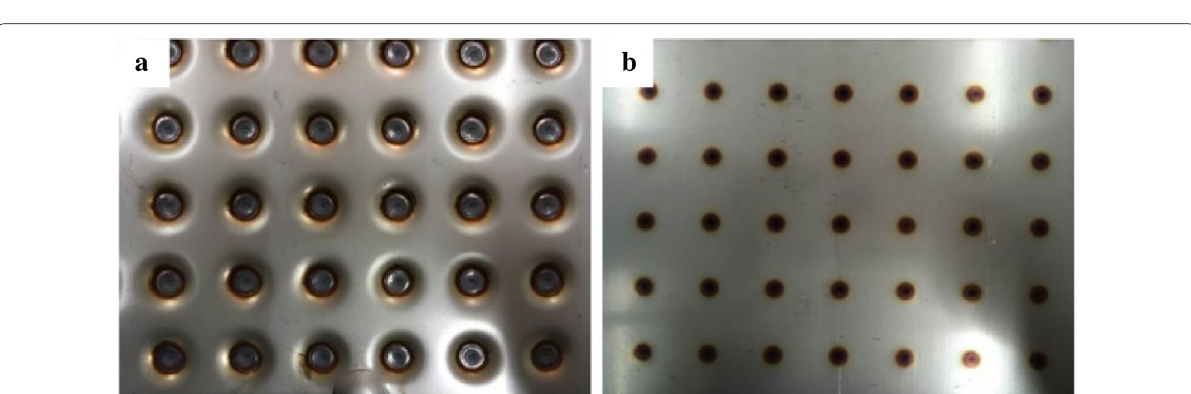
Figure 30 Welding seam morphology of the plate-pair laser welding of the lubricating oil cooler: a The front side of the weld; b The back of the